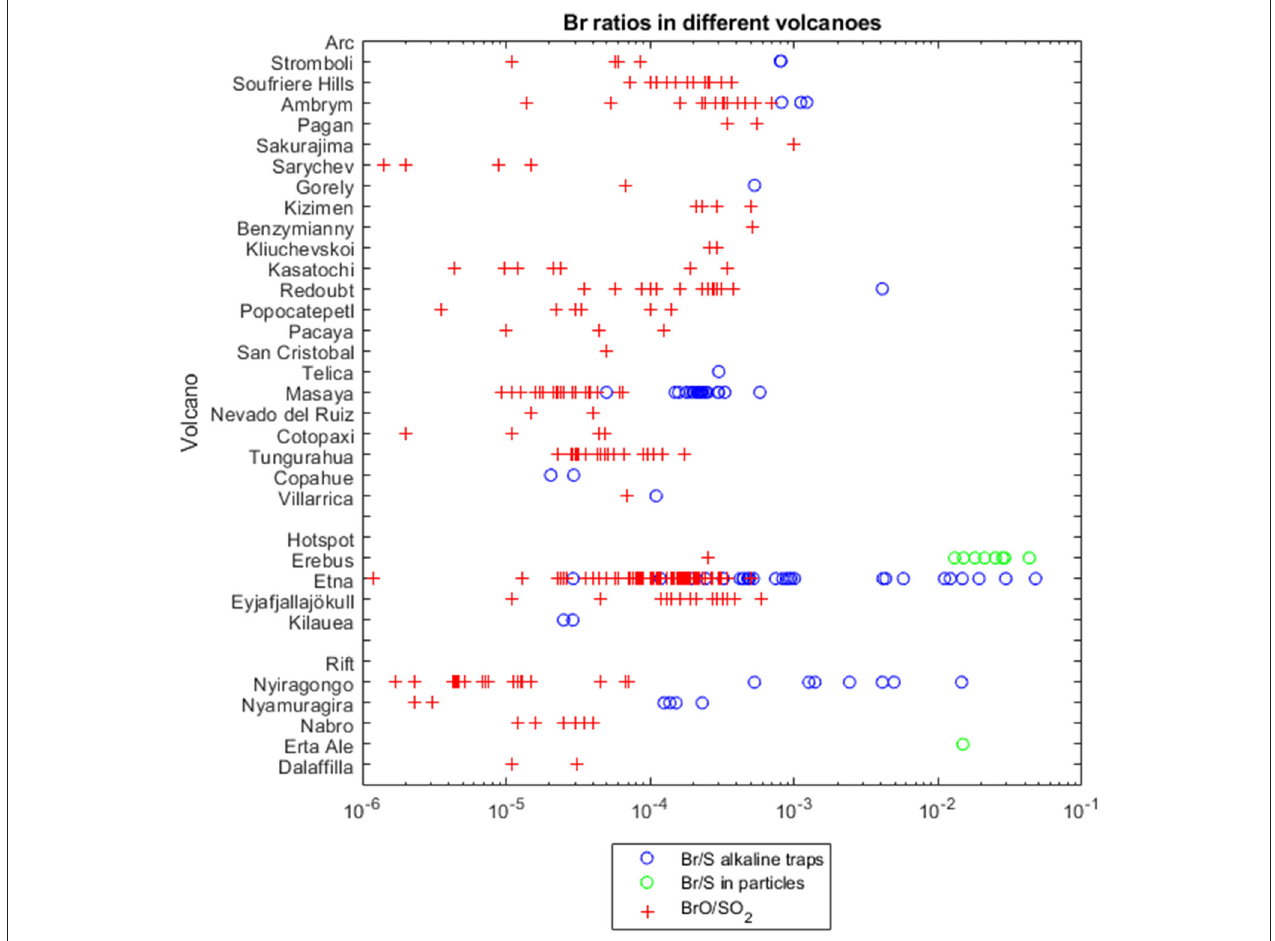
FIGURE 1 | Volcanoes and their bromine emissions. In blue circles Br/S ratios of total amounts measured by alkaline traps, in red crosses BrO/SO 2 ratios measured by DOAS instruments, in green circles Br/S ratios of total amounts in particles measured by particle filters. Data from Supplementary Table 1 , x-axis follows a logarithmic scale. Variability may be due to magma types and volcanic (tectonic) environments, volcanic activity, distance to the source and chemical aging, or measurement uncertainties (see section Overview of BrO/SO 2 and Br/S